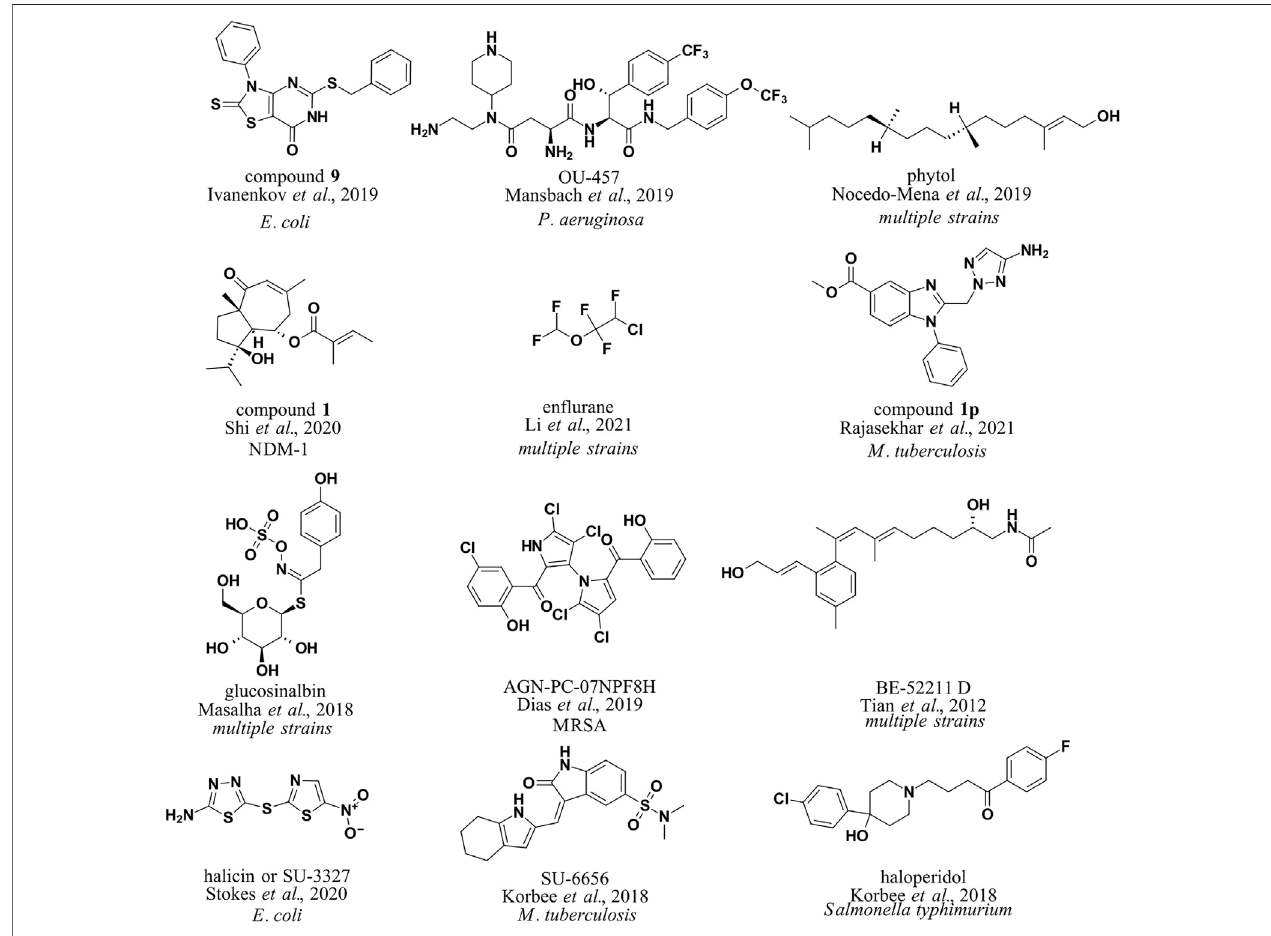
FIGURE 2 | Antibacterial compounds identi fi ed by machine learning boosted in silico methods in CADD.